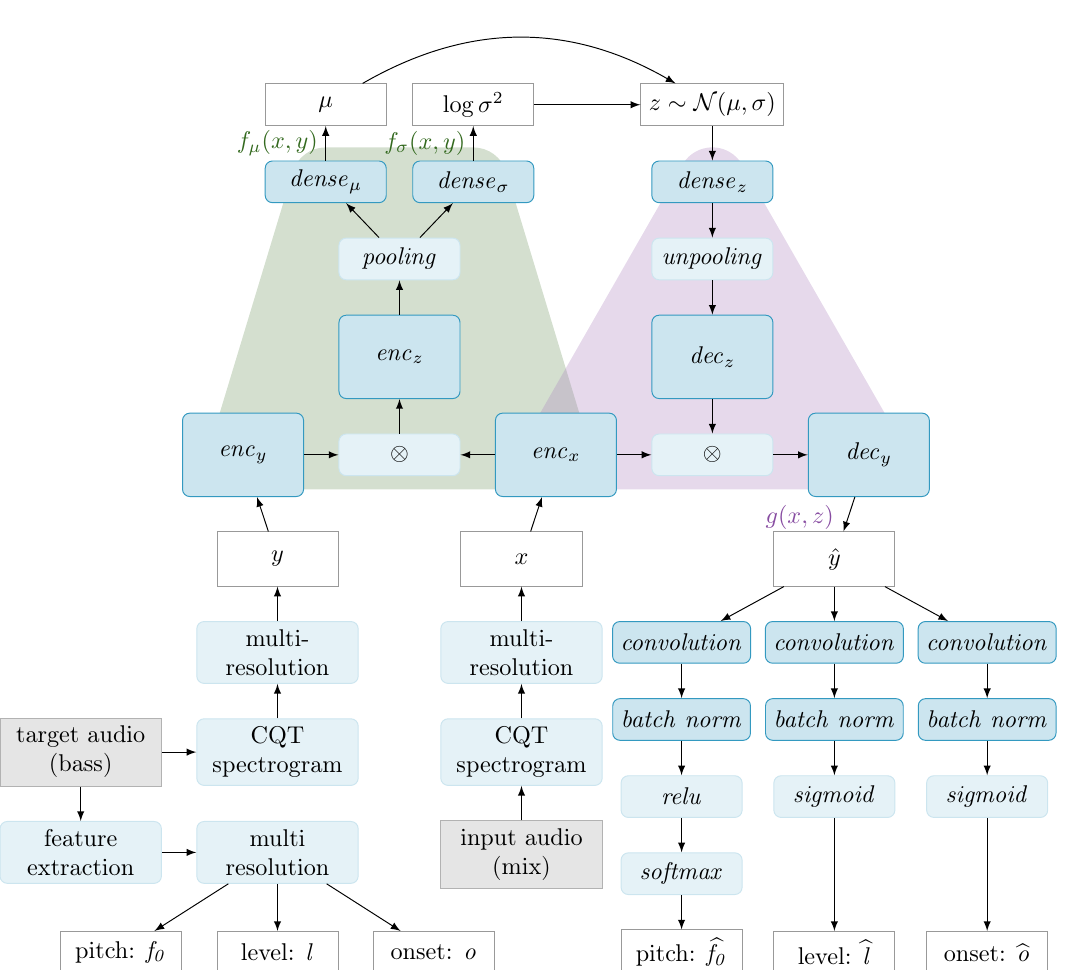
Figure 1. The BassNet model architecture and information flow. The input and target data of the model are shown as grey boxes. Functions are shown as blue rounded boxes. Dark blue boxes depict functions with trainable parameters. White boxes depict computed quantities. The sign denotes element-wise ⊗ multiplication. The green and purple planes denote the parts of the graph that correspond to the encoder functions f µ / f σ , and the decoder function g , respectively. The enc / dec boxes represent dilated residual encoders/decoders (Section 4.4.1). The CQT spectrogram computation, feature extraction, and multi-resolution processes are discussed in Sections 4.1–4.3,